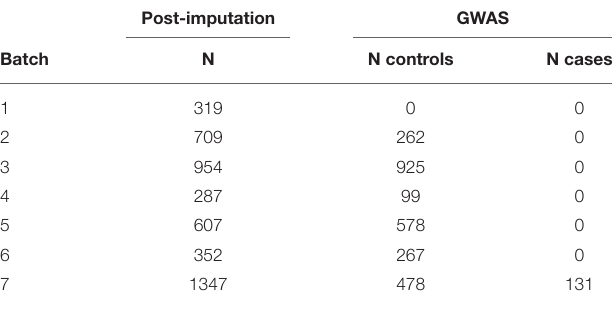
TABLE 1 | Batch distribution of cases and